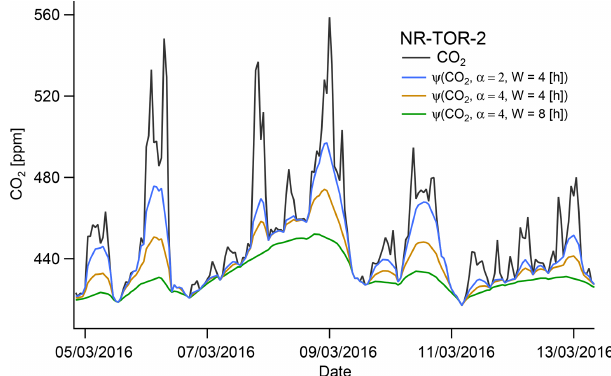
Figure 4. Method 3 applied to hourly CO 2 concentrations (black) measured at NR-TOR-2. The effects of varying the input parameters α and W are shown in blue, orange, and